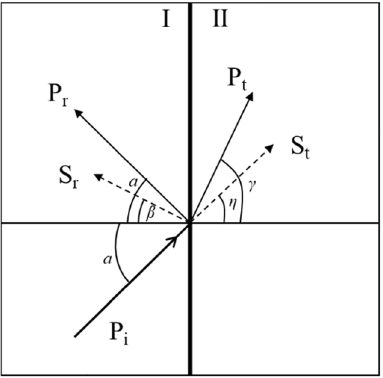
Figure 1. P i incident in inhomogeneous